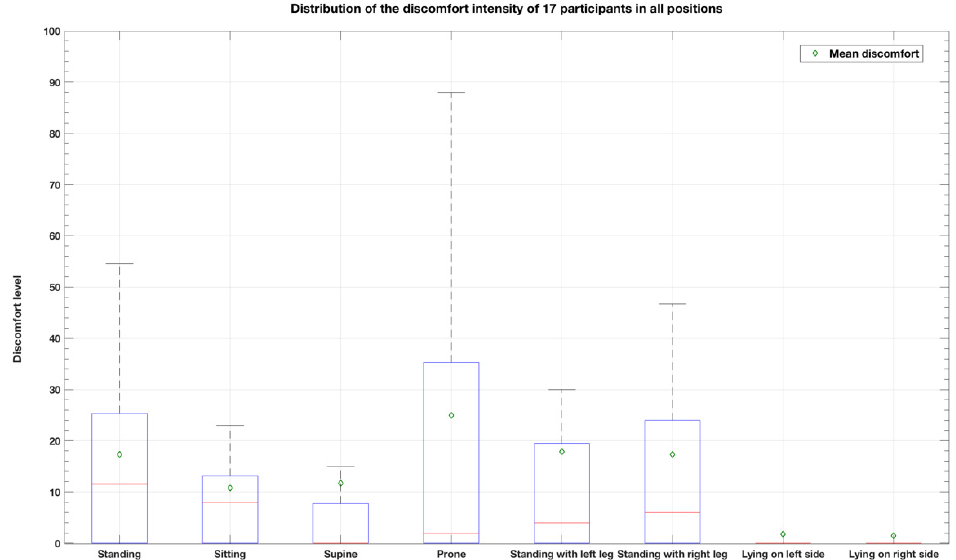
Figure 5. Distribution of the discomfort intensity of 17 participants in all positions.